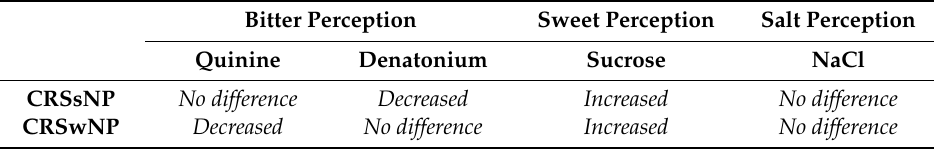
Table 1. Subjective taste intensity ratings in patients with chronic rhinosinusitis (CRS) without